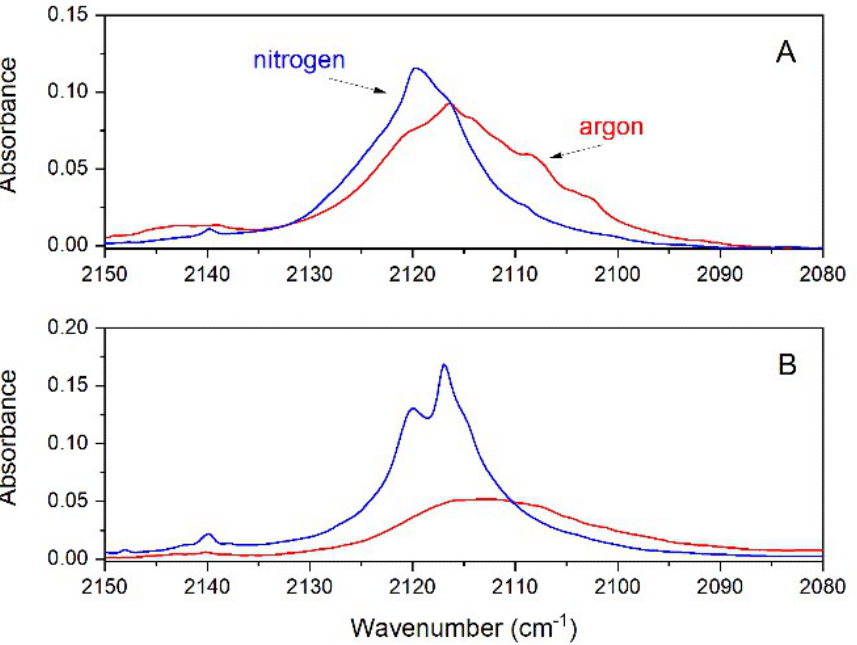
Figure 4. The 2150–2080 cm − 1 region of the difference spectra of: ( A ) the CHOCHO/NH 2 OH/Ar(N 2 ) matrix after 90 min of irradiation minus the freshly deposited CHOCHO/NH 2 OH/Ar(N 2 ) matrix; ( B ) the CHOCHO/ND 2 OD/Ar(N 2 ) matrix after 90 min of irradiation minus the freshly deposited CHOCHO/ND 2 OD/Ar(N 2 ) matrix.